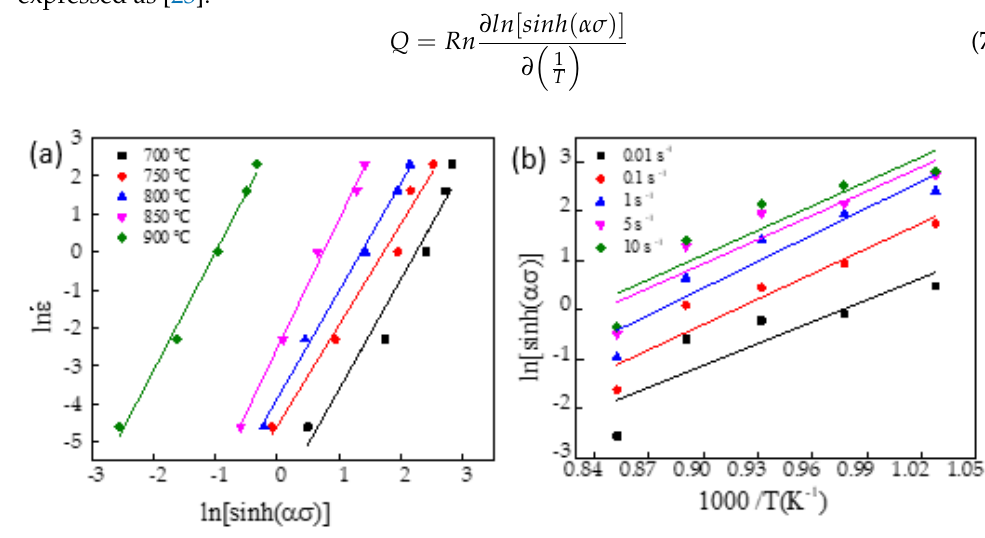
Figure 5. Relationship between( a ) lnε(cid:4662) − ln𝜎 , ( b ) σ − lnε(cid:4662) .